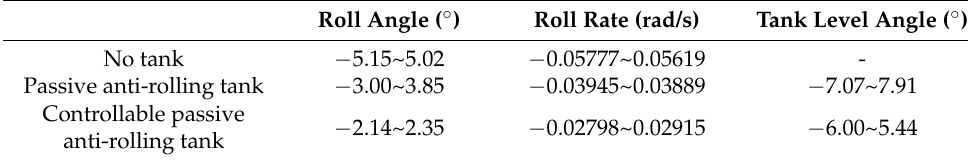
Figure 13. Tank level angle of passive anti-rolling tank and controllable passive anti-rolling tank. Table 4. Maximum roll response data.